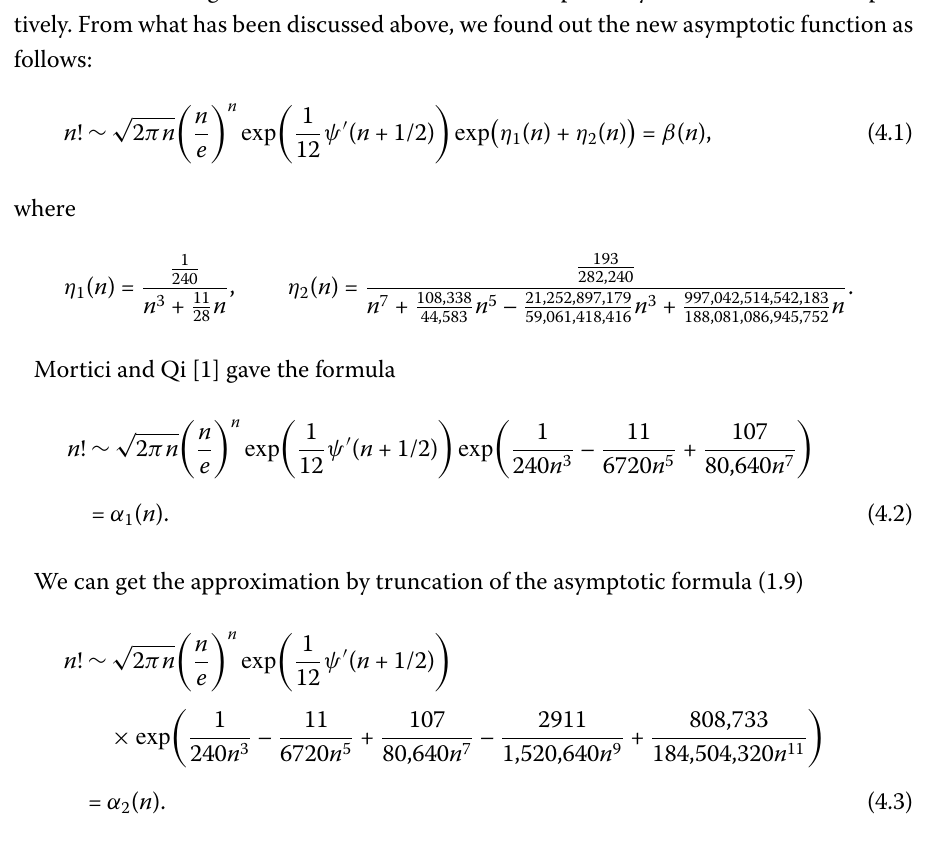
Table 1 Simulations for α 1 ( n ), α 2 ( n ) and β ( n )